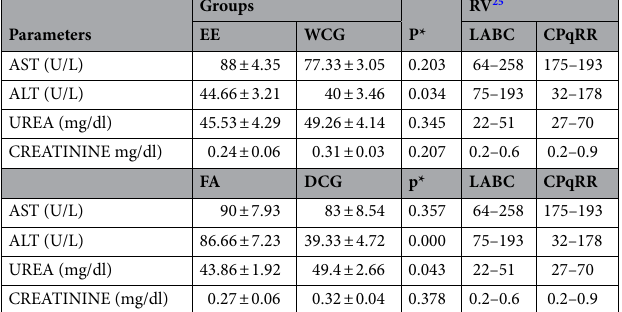
Table 4. Biochemical parameters of mice treated orally with a single dose of ethanolic extract or alkaloid fraction from Aspidosperma nitidum. EE ethanolic extract, FA fraction of alkaloids, WCG water control group, DCG DMSO control group (99% water + 1% DMSO), AST aspartate aminotransferase, ALT alanine aminotransferase, RV reference value, LABC Laboratory Animal Breeding Center, CPqRR René Rachou Research Center. * p value was obtained by Student’s T-test, comparing EE versus WCG, or FA versus